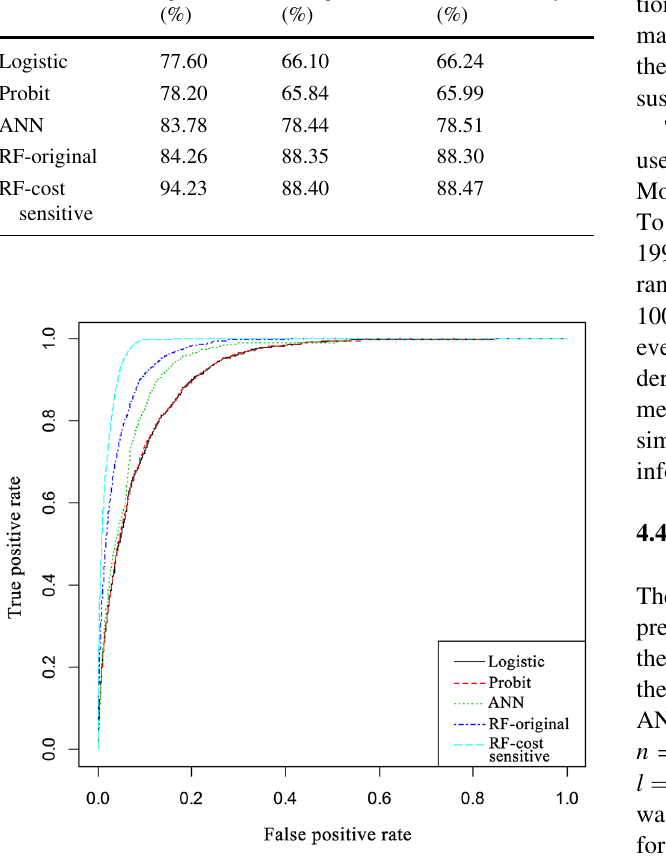
Fig. 6 ROC curves of the five